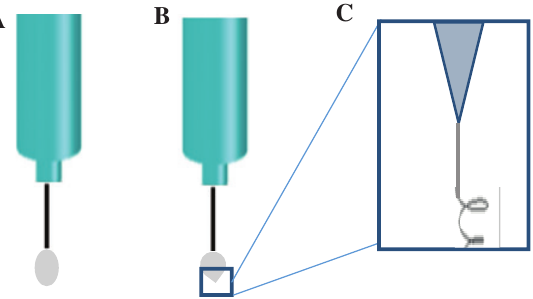
Figure 4: Schematic showing the evolution of an ES fiber. (A) Polymer is forced via syringe pump or pneumatic pressure to syringe tip, forming a polymer droplet. (B) Electrostatic voltage initiated in the collection electrode creates an electrostatic force, which pulls the polymer jet into a Taylor cone. (C) At the tip of the Taylor cone, electrostatic force elongates